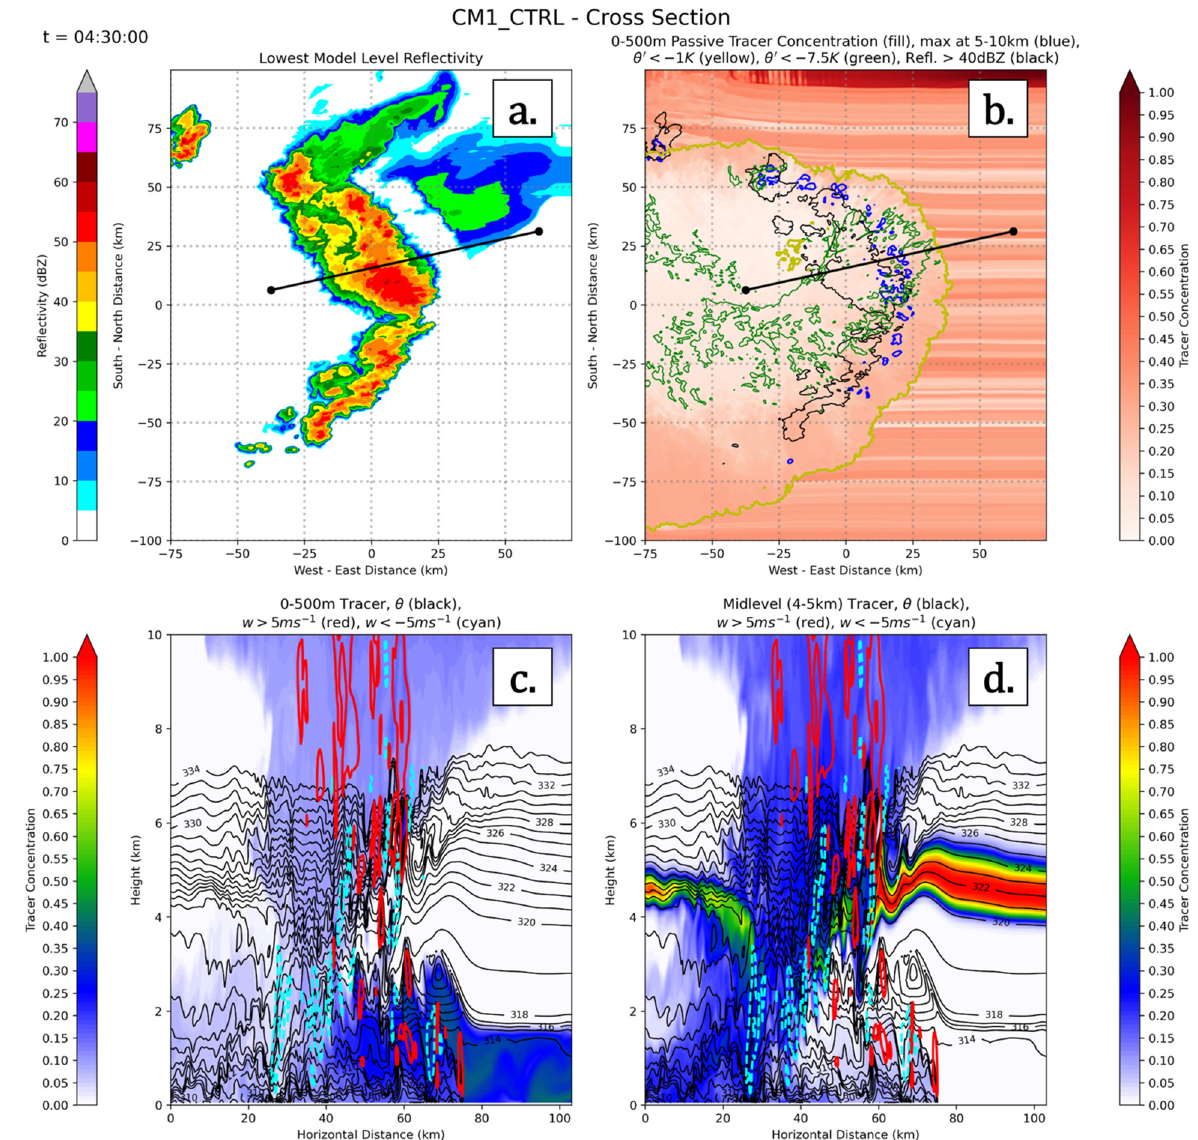
Figure 14. CM1 CTRL experiment for the MCS event at t = 4.5 hr., with ( a ) lowest-model level reflectivity and ( b ) 0–500 m tracer concentration (fill), reflectivity > 40 dBZ (black), surface potential Table 1. and − 7.5 K (yellow, green), ( c ) cross-section of 0–500 m tracer concentration, potential temperature (black), and vertical velocity (red/cyan), and ( d ) as in ( c ) but for the 4–5 km tracer concentration. In ( b ), the blue lines indicate where the maximum 0–500 m tracer concentration in the 5–10 km layer exceeds 0.2. The cross-section axis is denoted by the black line in ( a , b ).